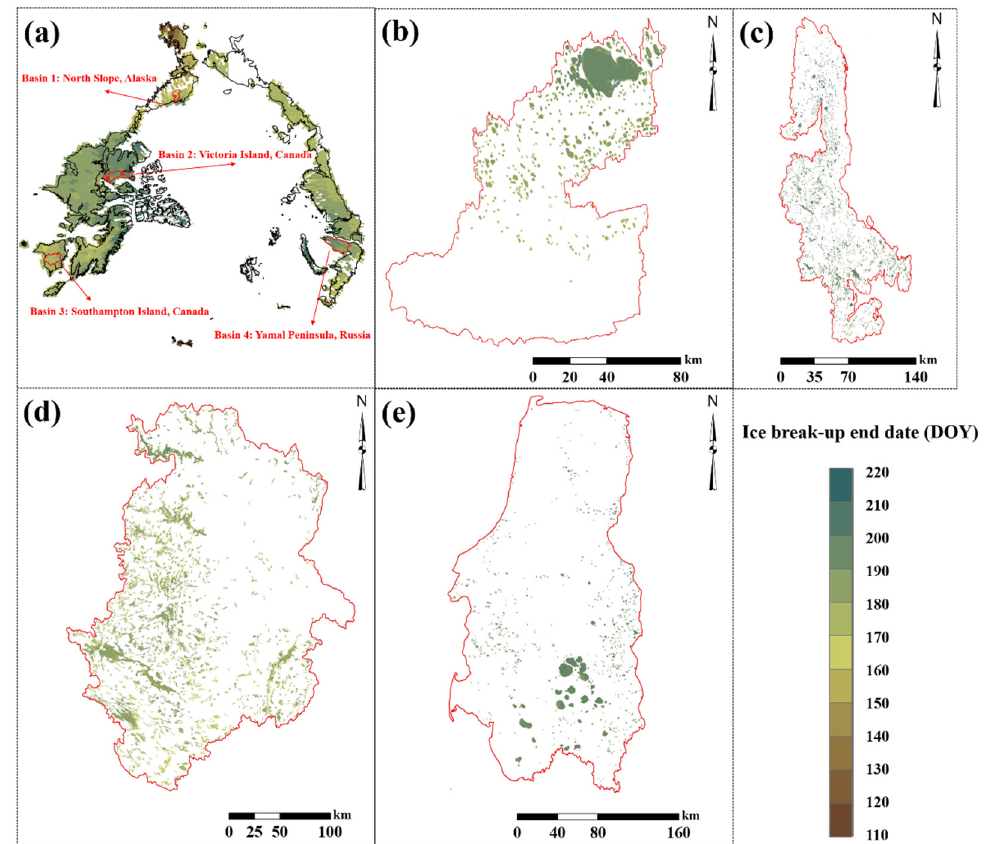
Figure 8. ( a ) Pan-Arctic lake ice BUE map for the year 2019 at a 25 km × 25 km tile scale. Four hydrological basins are highlighted for visual display at a 20 m spatial resolution, including ( b ) North Slope, ( c ) Victoria Island, ( d ) Southampton Island, and ( e ) Yamal Peninsula.